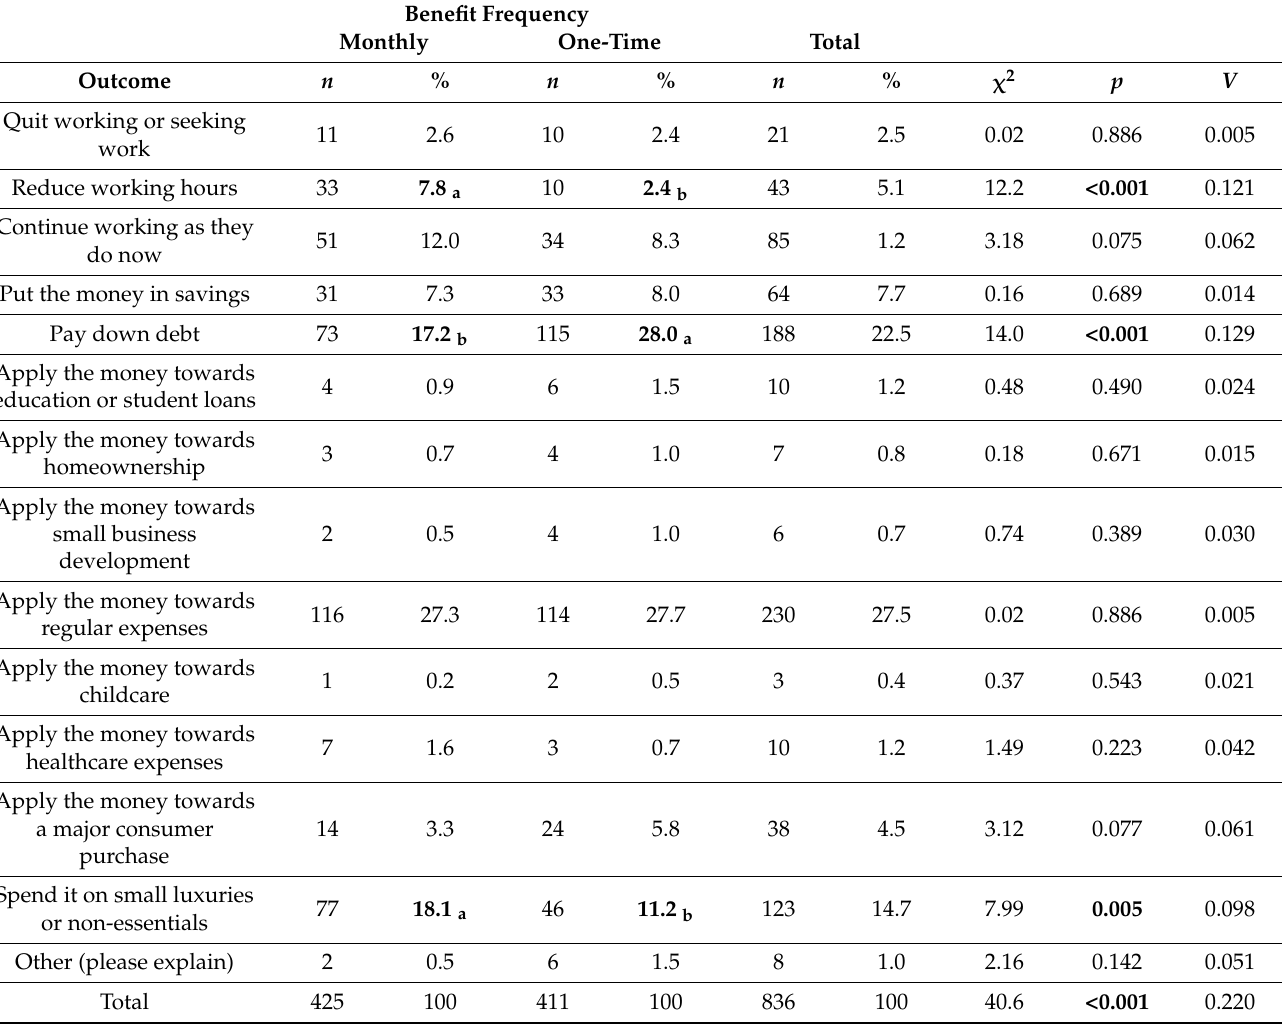
Table 3. Cross-tabulation of perceived outcomes of the adoption of UBI plans by benefit